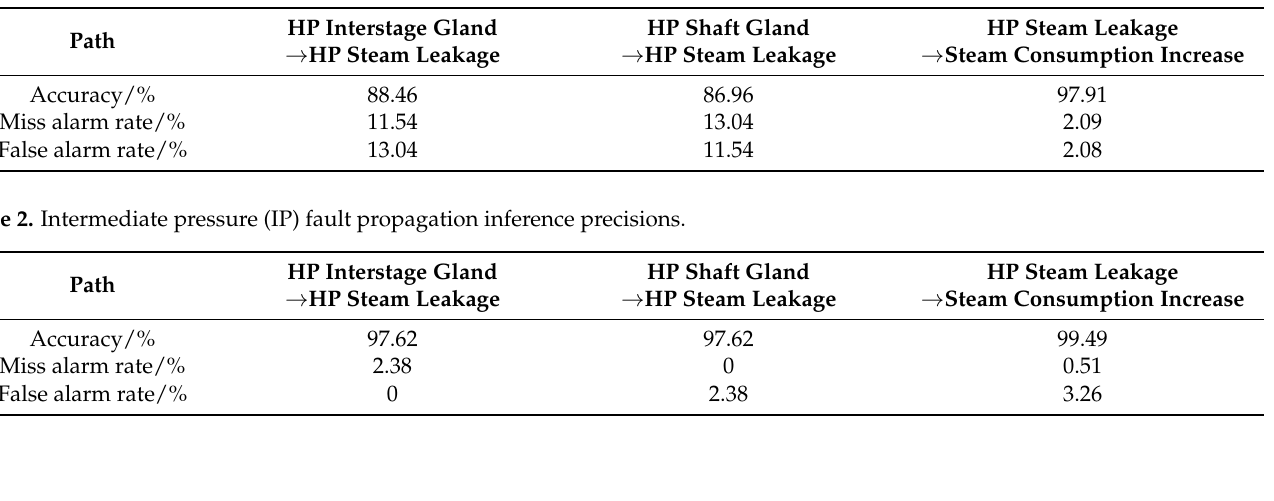
Table 1. High pressure (HP) fault propagation inference precisions.